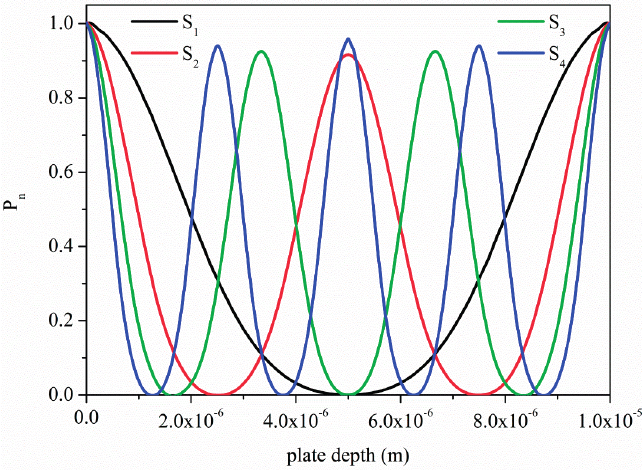
Figure 3. Normalized time-averaged power flow density P n of the first four symmetric modes propagating along a ZnO plate 10 µm